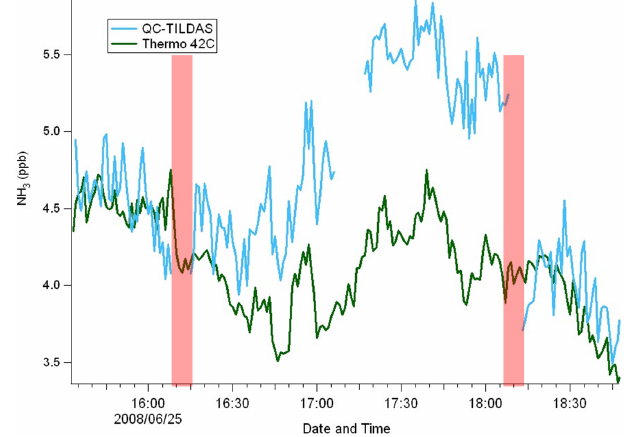
Fig. 7c. Time series of NH 3 from the QC-TILDAS and Thermo 42CTL indicate measurement drift for the QC-TILDAS due to changes in the background spectrum, which were not adequately captured with measurements of the background (indicated in red) every two